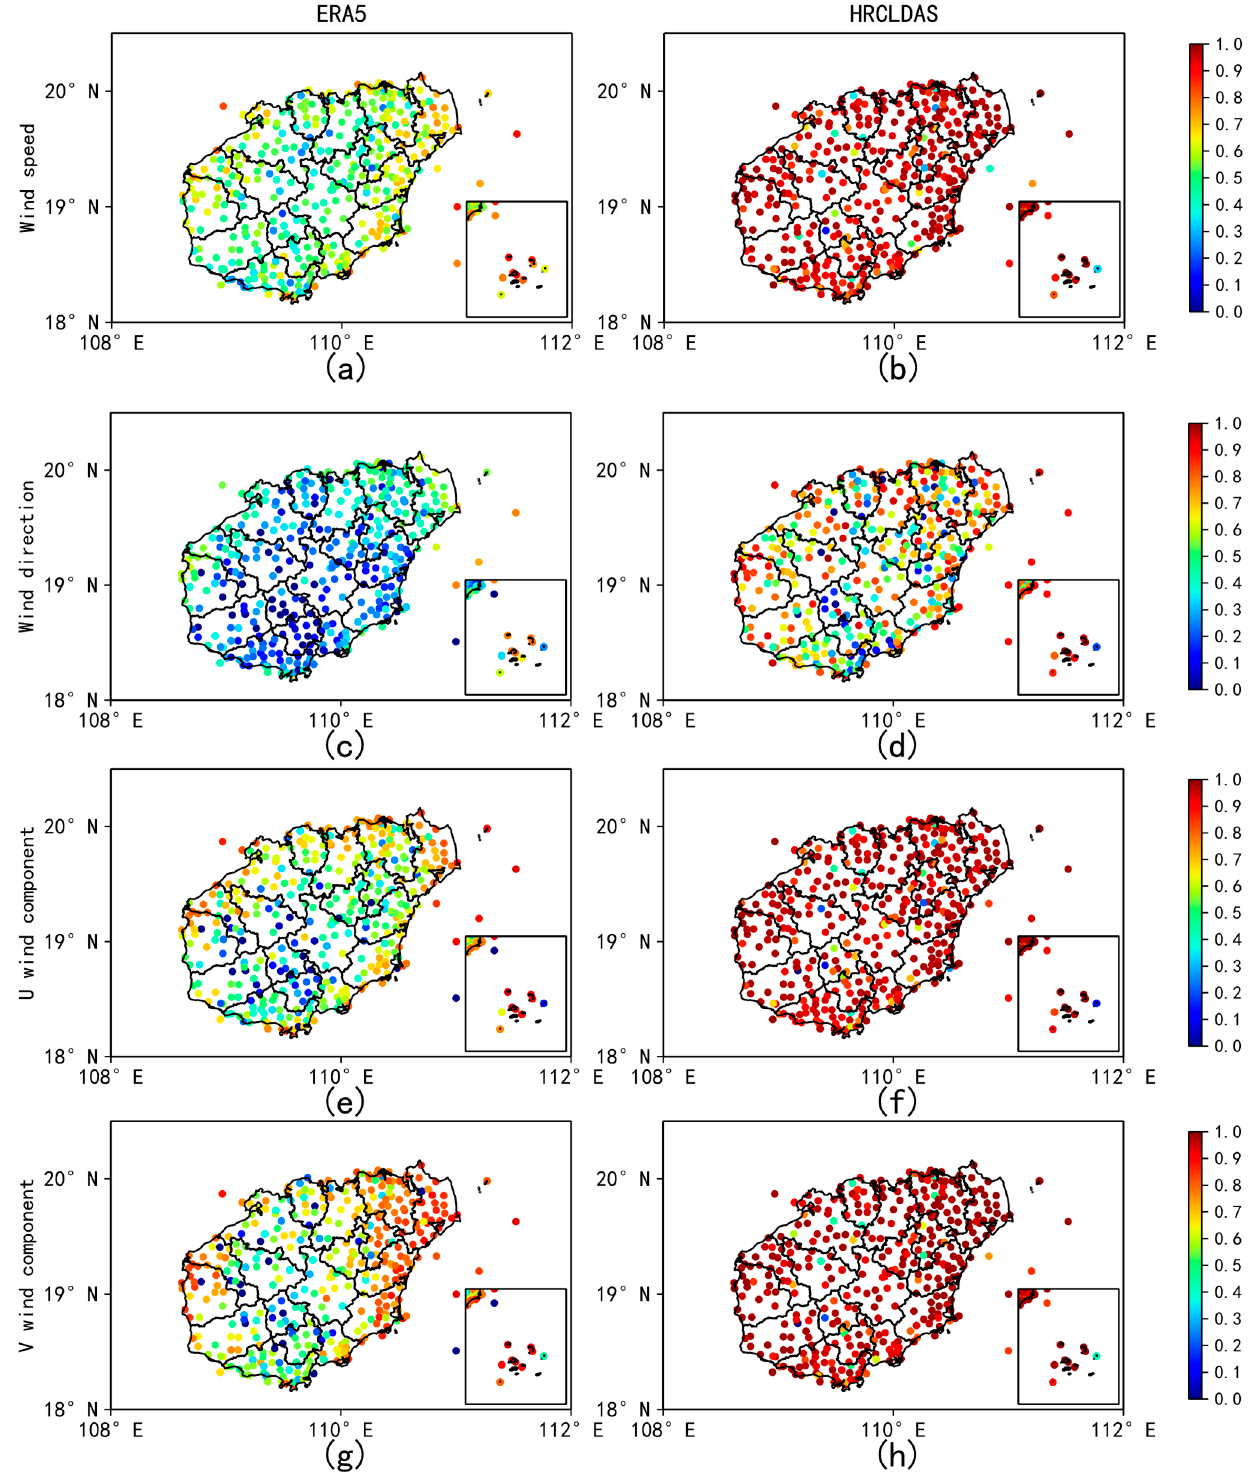
Figure 4. COR spatial distribution. ( a ) ERA5 near-surface wind speed, ( c ) ERA5 wind direction, ( e ) ERA5 U component, ( g ) ERA5 V component; ( b ) HRCLDAS near-surface wind speed, ( d ) HRCLDAS wind direction, ( f ) HRCLDAS U component, and ( h ) HRCLDAS V component.